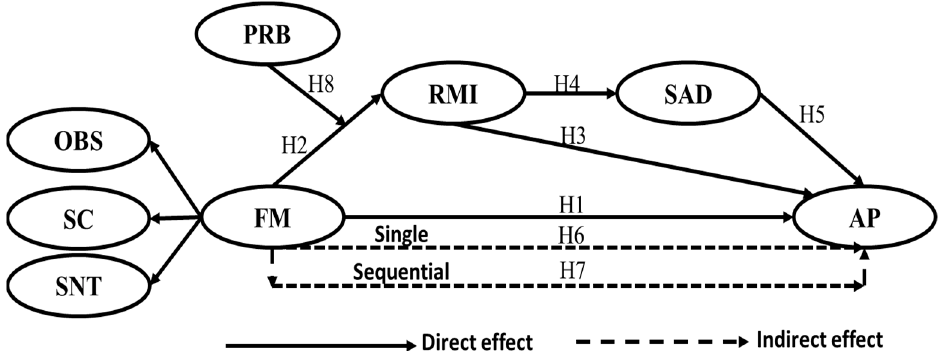
Figure 2. The proposed conceptual framework and hypotheses. FM: family micro-business resources, AP: agritourism performance, RMI: resident–micro-business interaction, SAD: support for agritourism development, PRB: personal resident benefit, SBO: small business orientation, SC: social capital, SNY: social network ties.